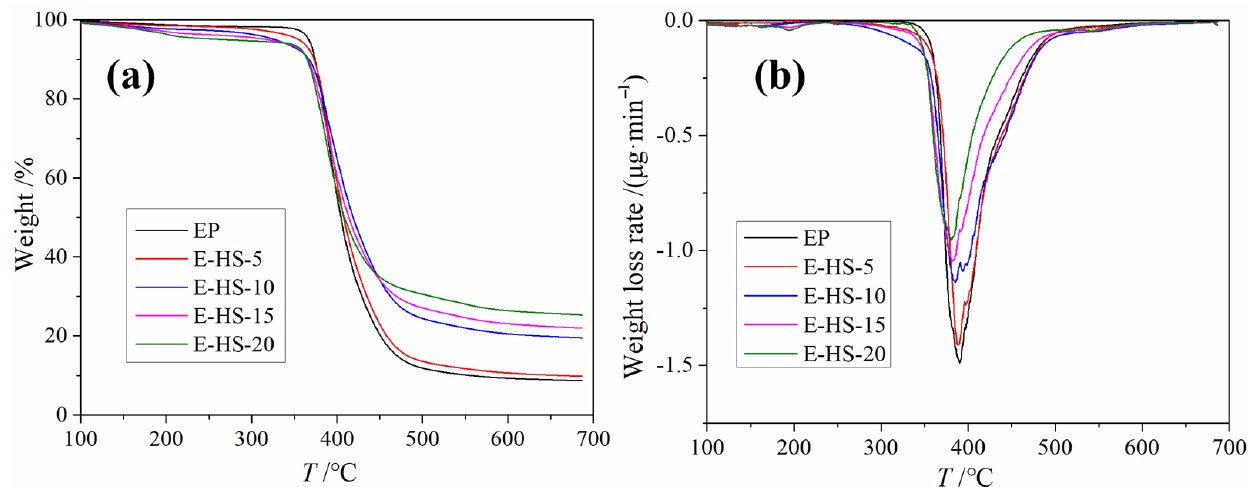
Figure 3. TG curves ( a ) and weight loss rate ( b ) of EP and E-HS-x.